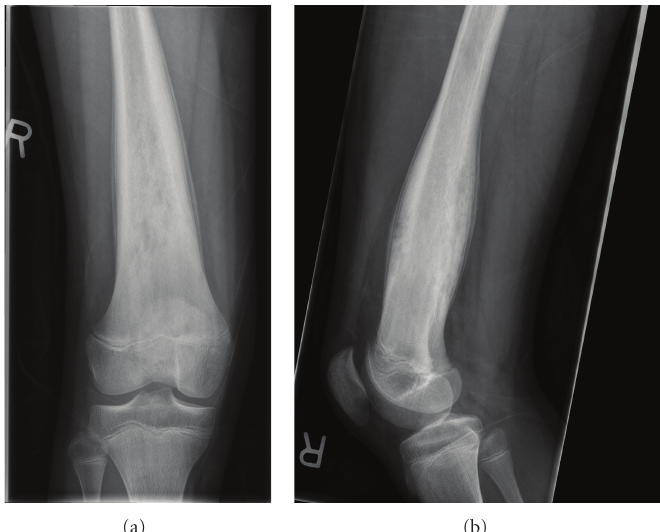
Figure 1: Frontal (a) and lateral (b) radiographs of the distal right femur. The lesion is shown as an expansile, fusiform mass in the distal femur, away from the growth plate. Medullary involvement is shown as patchy, moth-eaten lucencies. Smooth laminated onion-skin like periosteal reaction is also seen.